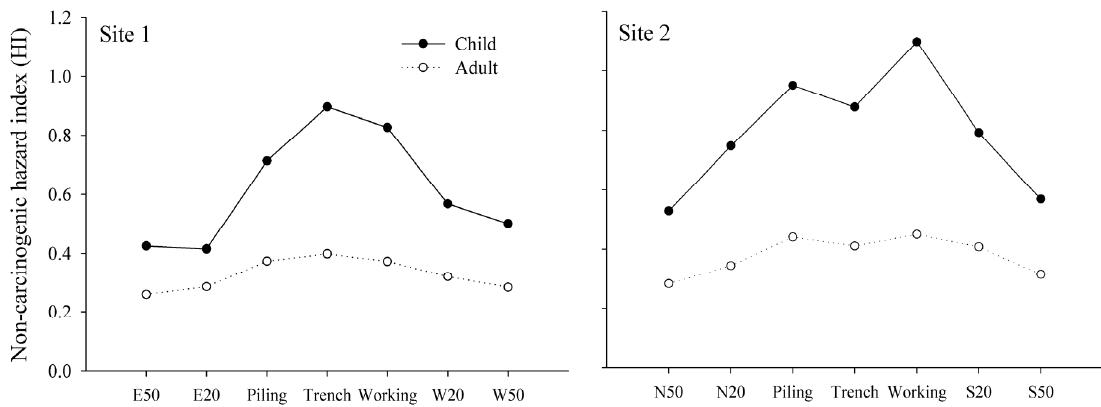
Figure 5. Non-carcinogenic hazard risk of children and adults at Sites 1 and 2 along the pipeline.